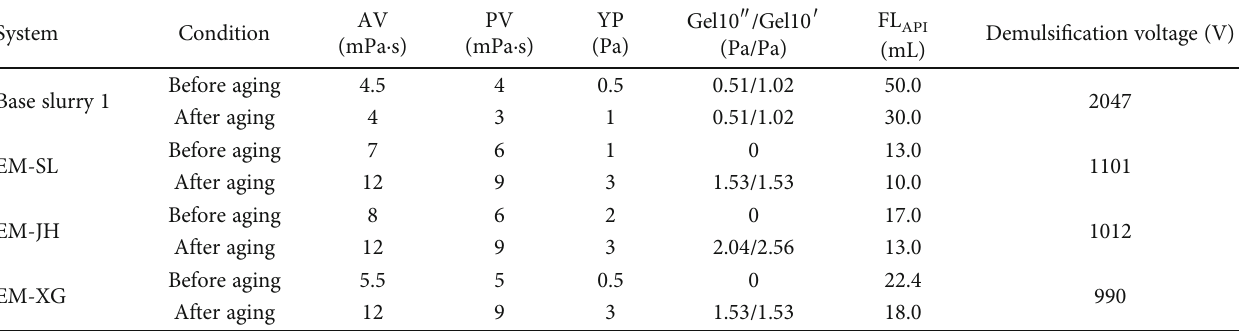
Table 5: Experimental results of emulsifying agent optimization.